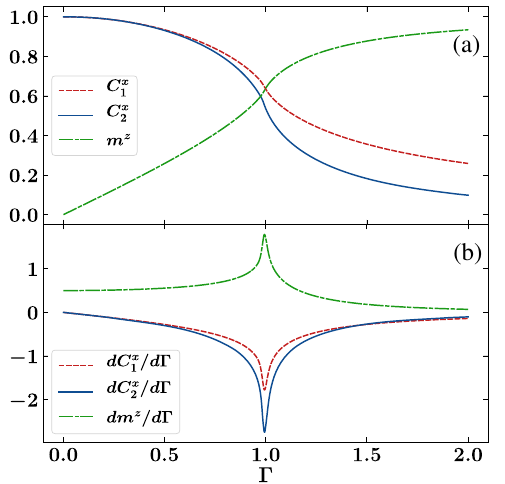
FIG. 14. Ground-state results for (a) C x derivatives, as functions of the strength of the transverse magnetic